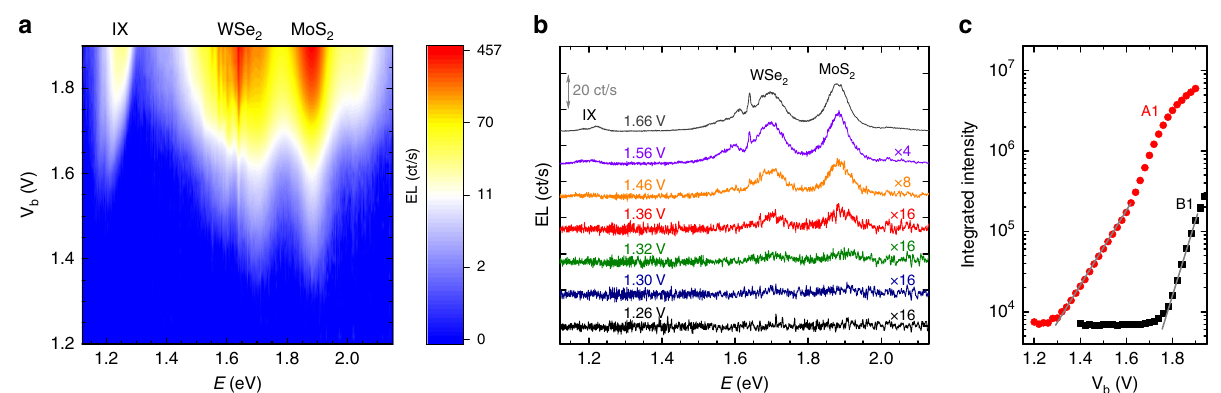
Fig. 3 Upconverted electroluminescence. a False color contour plot of the EL spectra as a function of bias voltage for sample A1 with a monolayer hBN spacer. b EL spectra for seven different bias voltages extracted from ( a ). The spectra are vertically shifted for clarity. For a voltage of V b = 1.32 V emission at energies up to around 1.9 eV are observed, clearly illustrating the large upconversion effect. c Comparison of the integrated EL intensity in the spectral range of intralayer emission (1.32 – 2.37 eV) as a function of bias voltage for sample A1 (red circles) and B1 (black squares). A background signal from the response at V b = 0 V was subtracted for each spectrum. The integrated EL intensity at voltages below the onset of observable emission corresponds to the noise level of our setup of around 2 ct/s per pixel (integrated over about 4000